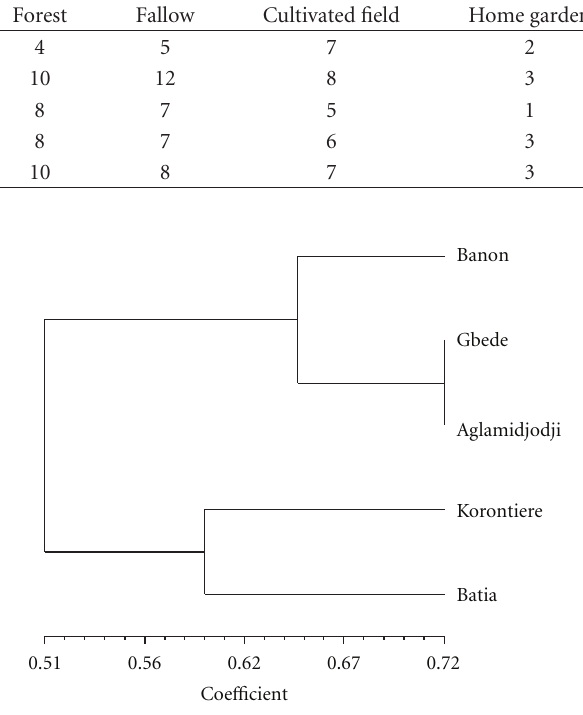
Table 2: Number of plant species under domestication per village and their distribution per type of plant and by habitat. Villages